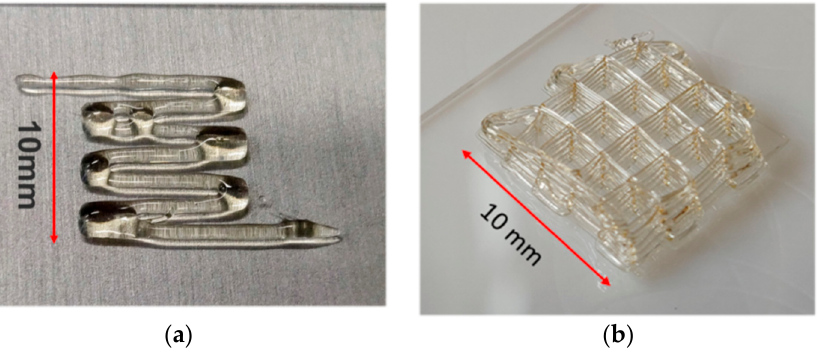
Figure 11. 3D printing attempts of ( a ) PEG 1500 UPy 2 /LiTFSI (EO:Li 5:1)( 1 ); ( b ) PEG 1500 UPy 2 /LiTFSI (EO:Li 5:1) mixed with 15% NP-IL ( 4 ).